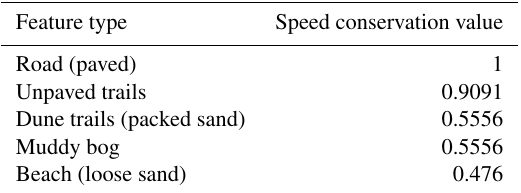
Table 4. Speed conservation values used in modeling pedestrian walking speed (Wood and Schmidtlein, 2012). Speed conservation values adapted from Soule and Goldman